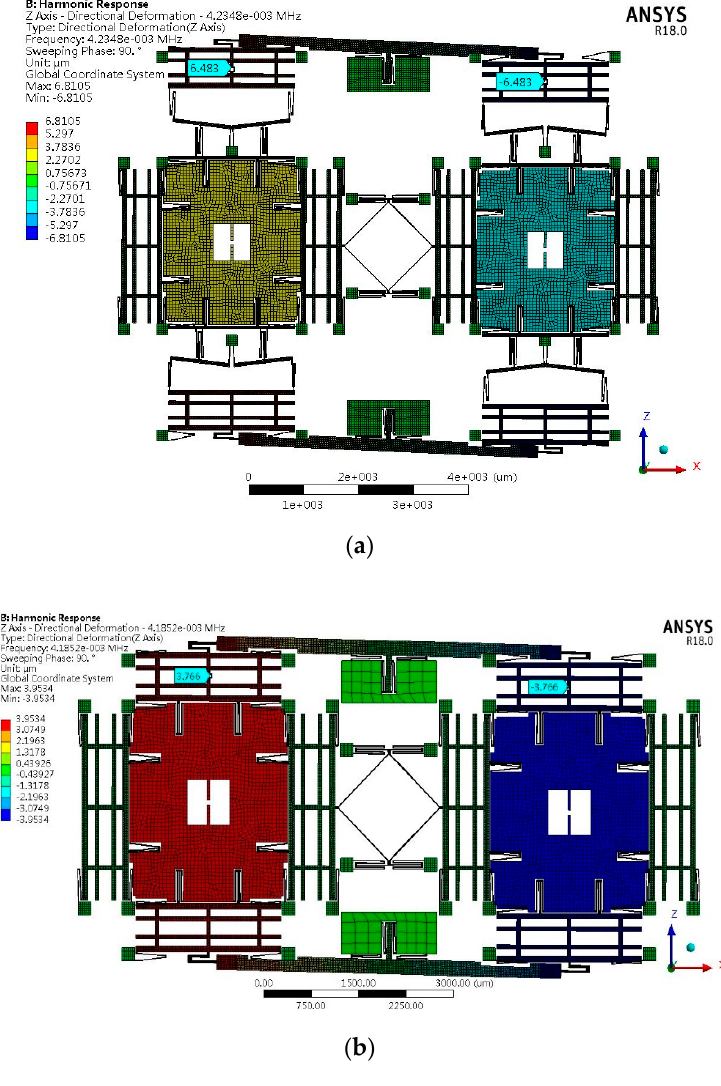
Figure 6. Directional deformation of harmonic response analysis in the sense-mode resonance frequency of ( a ) type A1 and ( b ) type B.